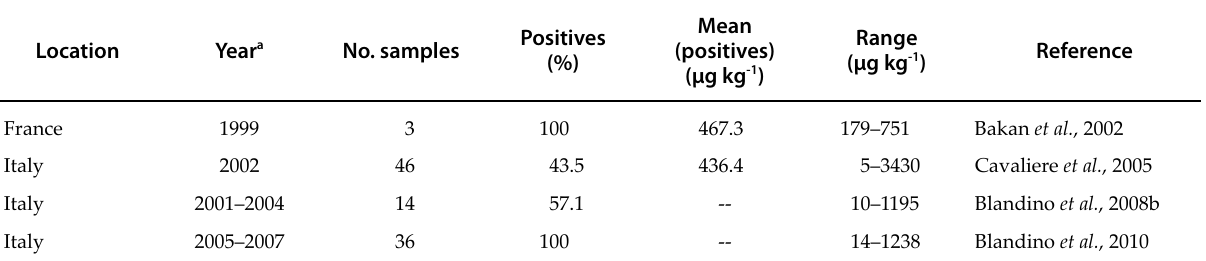
Table 4. Occurrence of deoxynivalenol in freshly harvested maize from Mediterranean countries.